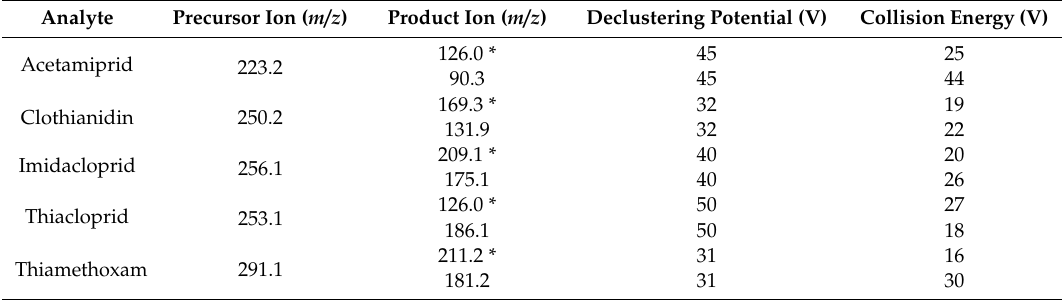
Table 4. Precursor, quantification (*), and confirmation ions used in the selected reaction monitoring (SRM)